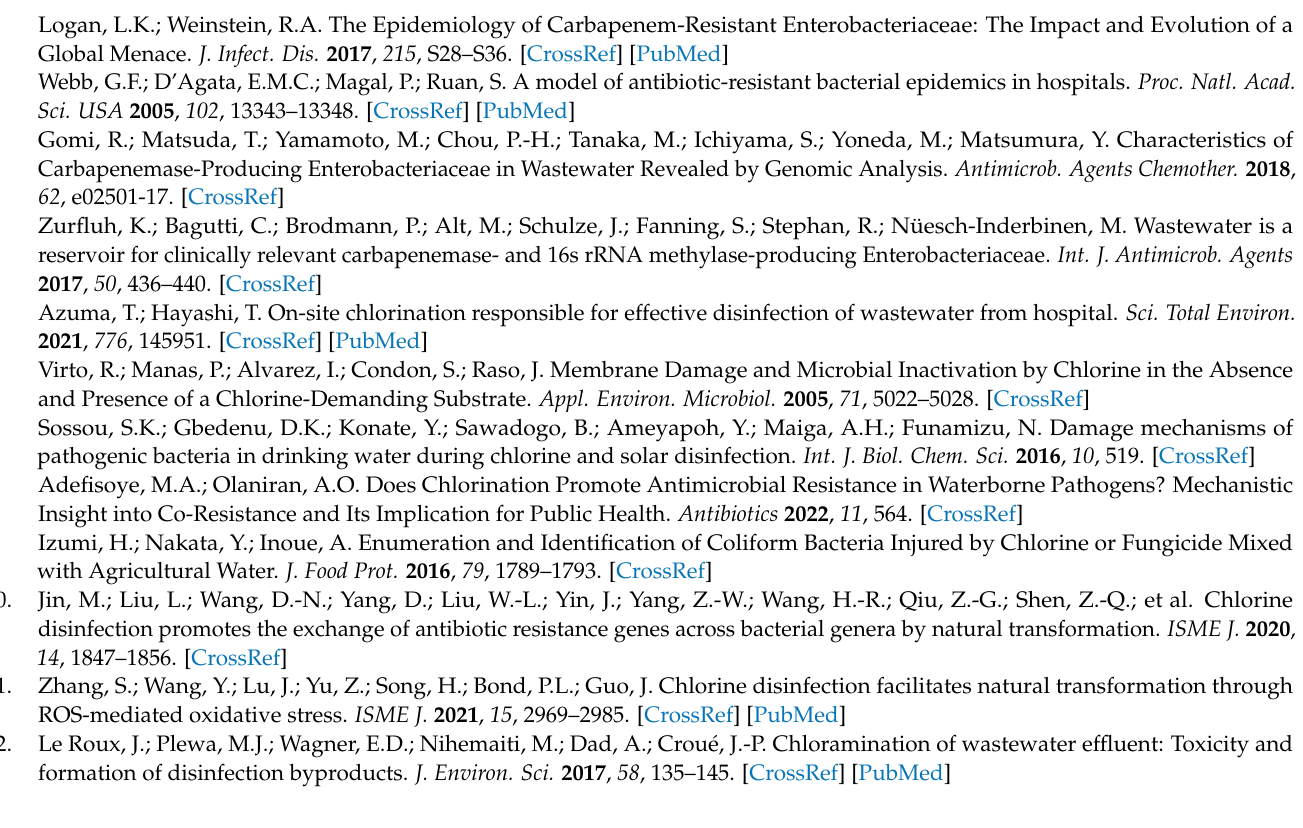
primers and parameters; Table S2: Table showing clonal relationships between tested